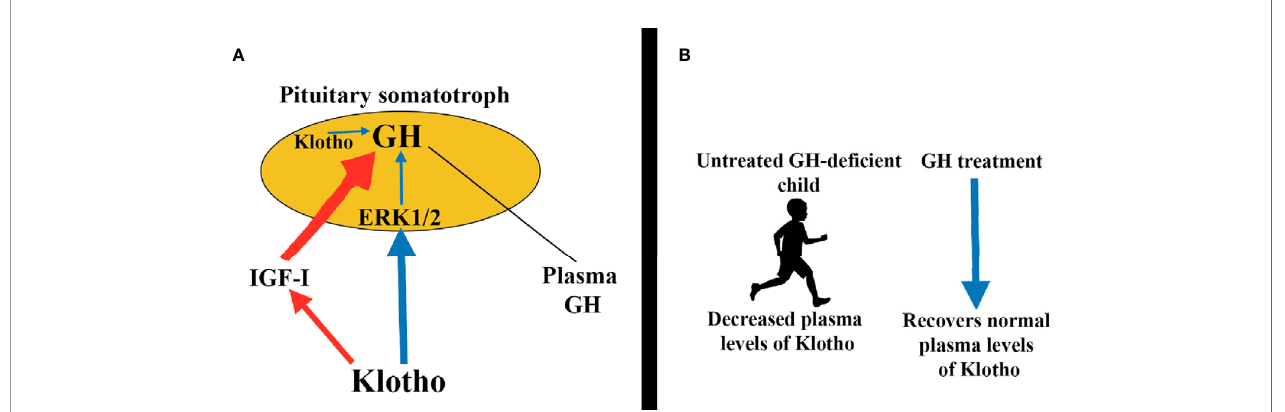
FIGURE 8 | Klotho induces pituitary GH secretion. (A) Circulating klotho directly stimulates GH secretion by activating the ERK1/2 pathway (blue arrows). Indirectly, klotho also promotes GH secretion by inhibiting IGF-I and consequently its inhibitory effects on GH release (red arrows). Additionally, klotho is expressed in